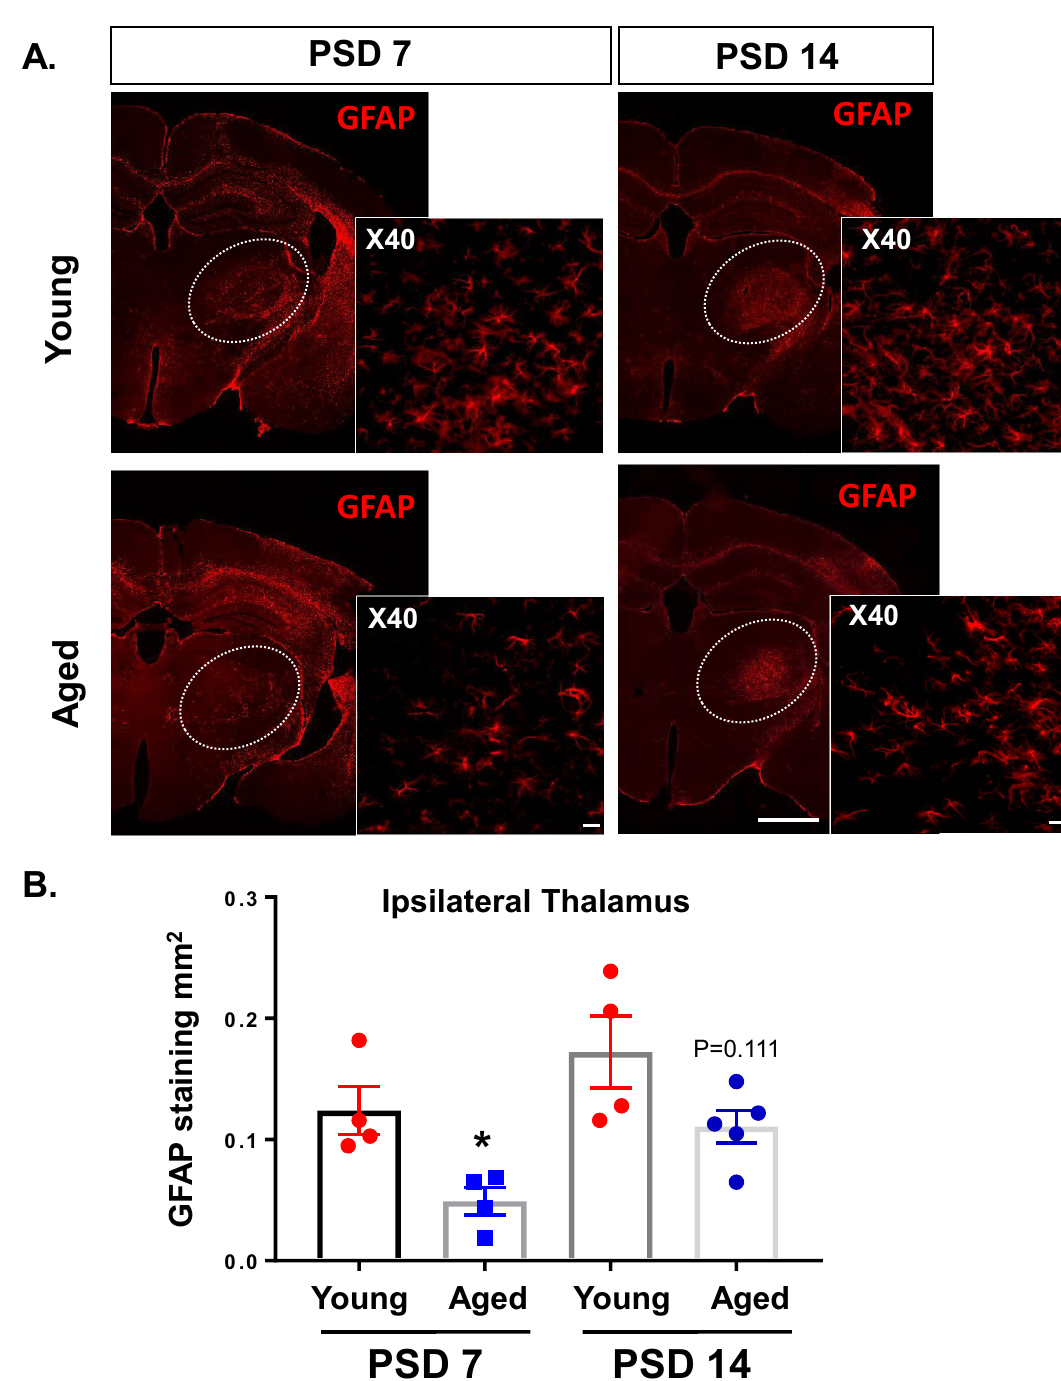
Figure 6. Aged mice demonstrate reduced astrogliosis in ipsilateral thalamus at PSD 7 compared with young mice. GFAP expression was evaluated at PSD 7 and PSD 14 in ipsilateral thalamus from young and aged mice. ( A ) Representative images showing GFAP expression in coronal sections at -2 mm from bregma (10X obj, stitched image; scale bar = 1 mm). Insert images was taken at 40X, scale bar = 20 µm. ( B ) Quantification of total GFAP stained area in ipsilateral thalamus of young and aged mice. * P < 0.05, unpaired t test. ( P = 0.111 for young versus aged at PSD